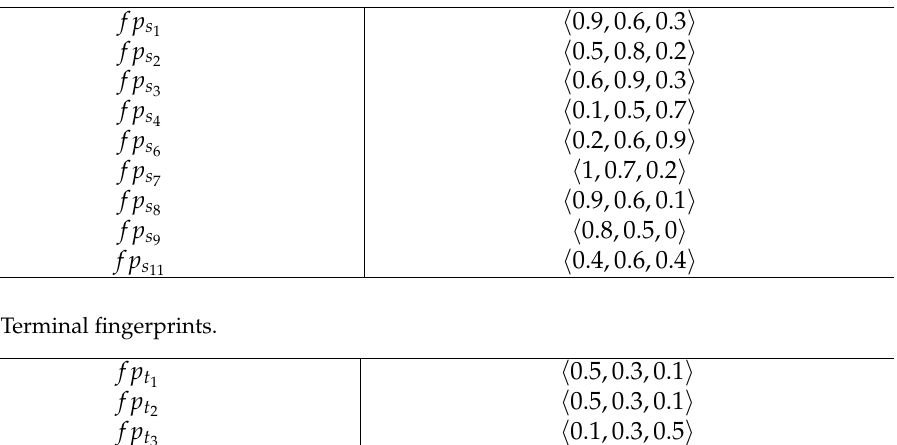
Table 1. Slot fingerprints.